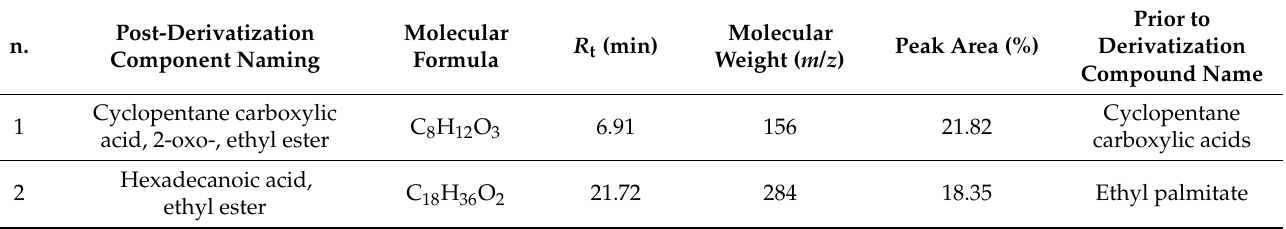
Table 3. GC-MS-MS profile of Roselle ethyl